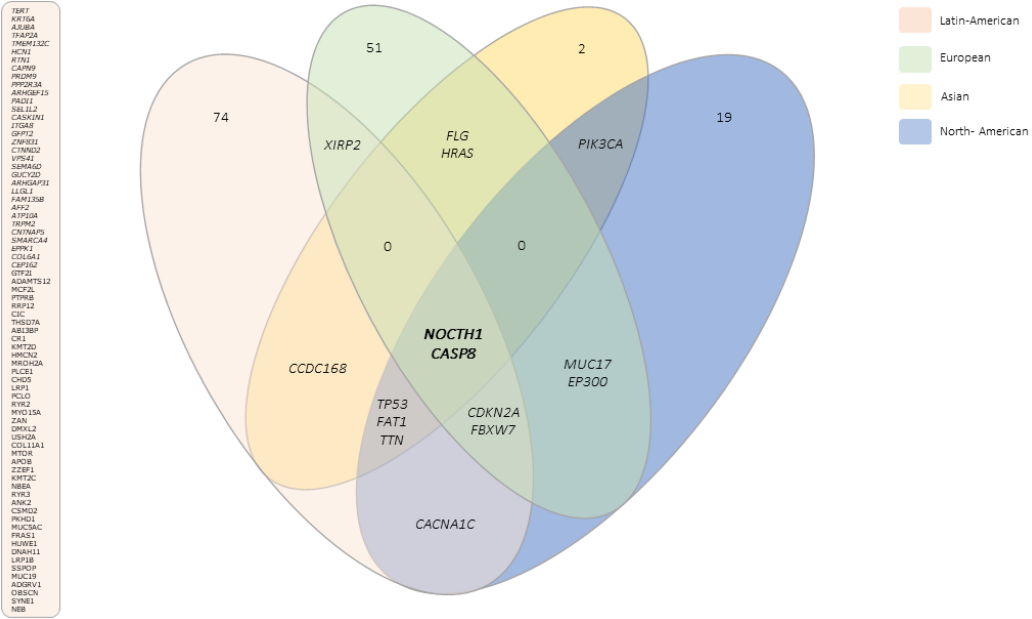
Table S7). The CSMD3 gene (regulated by miR-1237-3p, miR-224-5p, and miR-132-3p) presented the highest number of hybridization regions affected by the c.-19T > C variant (sites for miR-1237-5p). In addition, the ‘c.-19T > C’ variant has not yet been described in Cancers 2022 , 14 , x FOR PEER REVIEW the dbSNP and COSMIC databases.